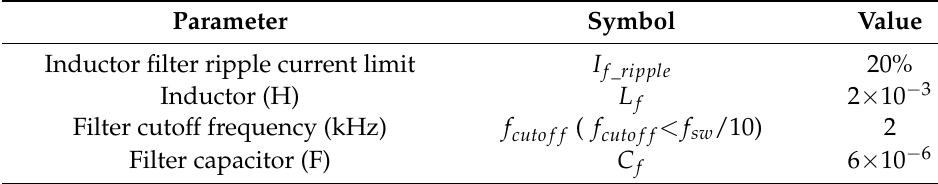
Table 2. Specifications of the inverter output